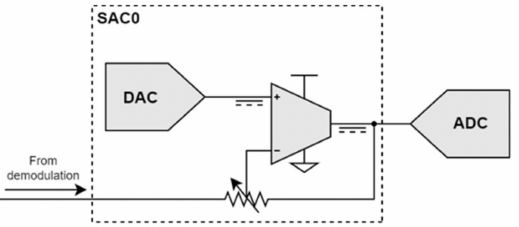
Figure 12. MSP430 SAC in inverting mode and